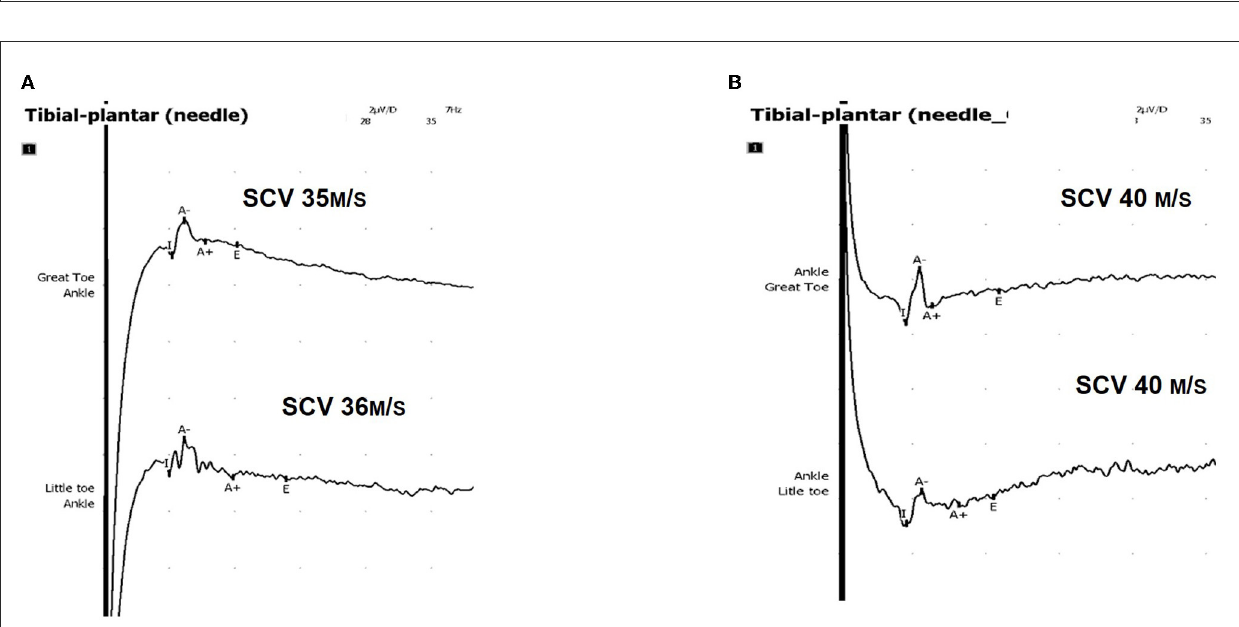
FIGURE3 Ultrasound-guided near-nerve needle sensory technique (USG-NNNS) applied to the tibial nerve. (A) Baseline recording, pre-USLIT. (B) Recording post-USLIT shows improvement with increased sensory conduction velocity (SCV).